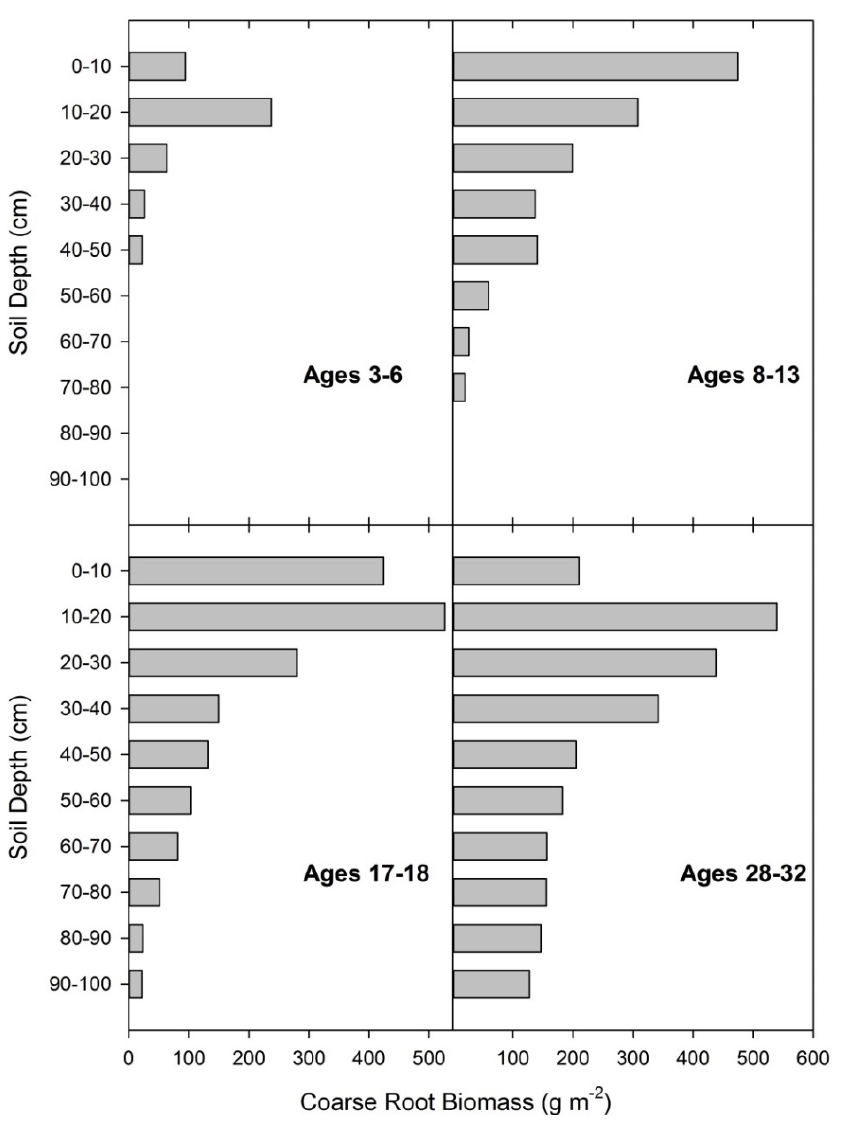
Figure 6. Coarse root biomass distribution by depth at four age ranges averaging 4, 11, 18, and 30 years. Data are from 11 destructively sampled loblolly pines on reclaimed mineland in east